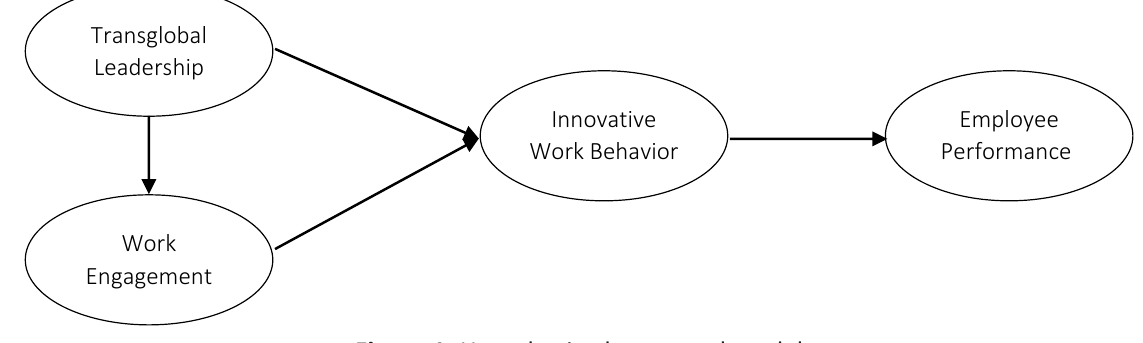
Figure 1. Hypothesized structural